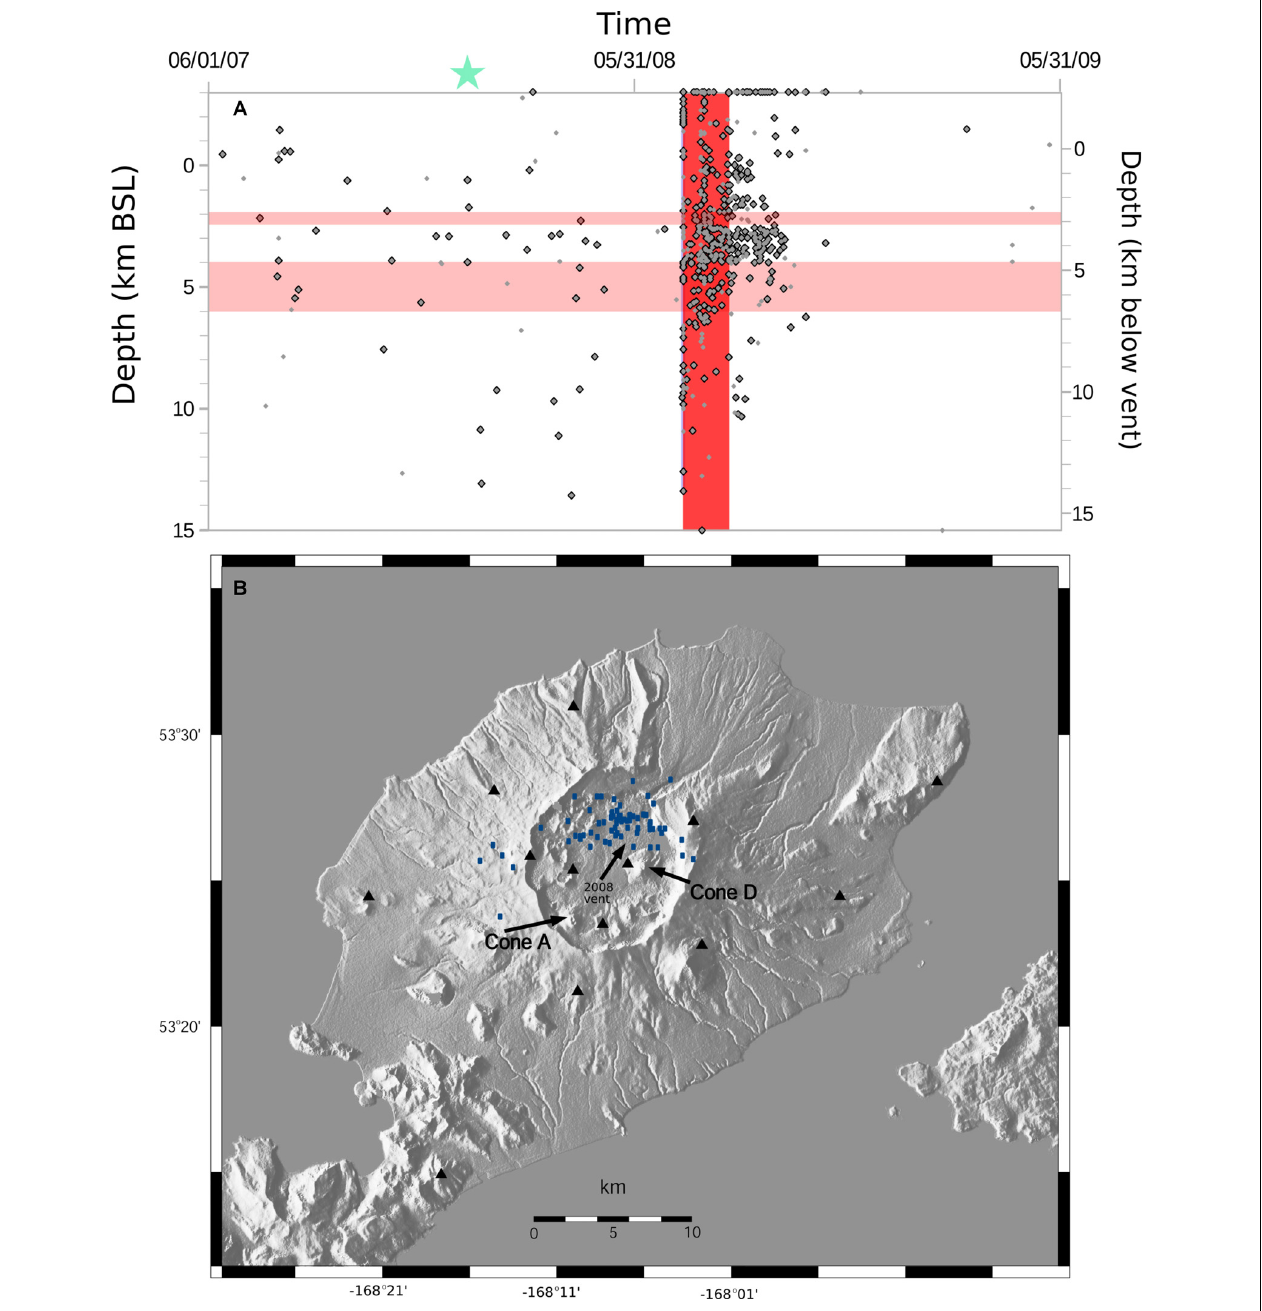
FIGURE 6 | (A) Time-depth plot for Okmok Volcano, Alaska from June 2006 to May 2009. Light red – petrologically-defined magma sources. Dark red – eruptions. Light blue shading shows the timing and depth of precursory seismicity. Gray dots show all earthquakes and black outlined dots show earthquakes with well-constrained locations. Green star indicates onset of GPS-detected deformation. (B) Map of Okmok showing epicenters of precursory earthquakes (blue squares) occurring in the 5 h preceding eruption, and the location of the 2008 vent relative to historic vents. Black triangles show the location of seismic